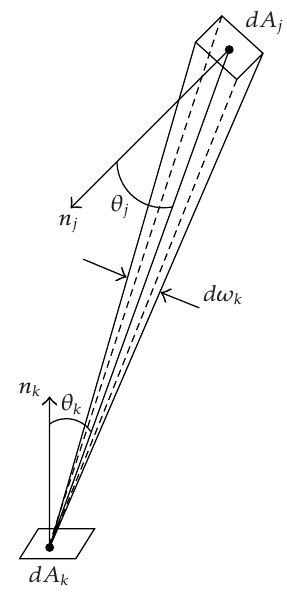
Figure 2.2. Calculation of the view